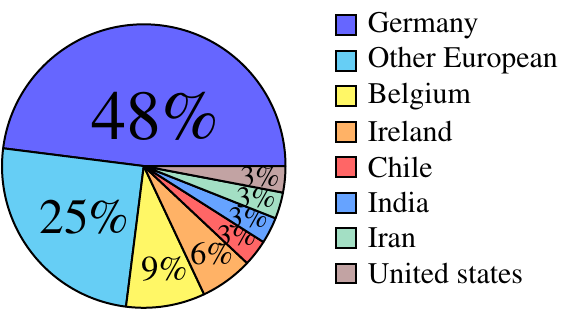
Figure A1. Origin of participants (n = 34).